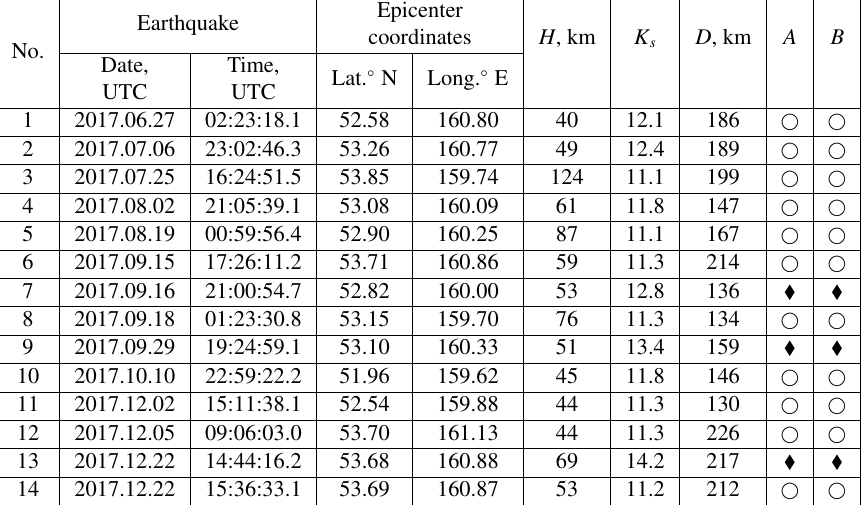
Table 1. Earthquake parameters based on which the manifestation of seismoacoustic and seismoelectric responses of near-surface sedimentary rock on the deformation by seismic waves were analyzed; K s is the earthquake energy class; D is the hypocentral distance to Karymshina site; A is the presence of joint seismoacoustic and seismoelectric responses of rocks ( (cid:7) ) or only their seismoacoustic response ( (cid:13) ); B is the presence of low-, mid- and high-frequency clusters ( (cid:7) ) or only of